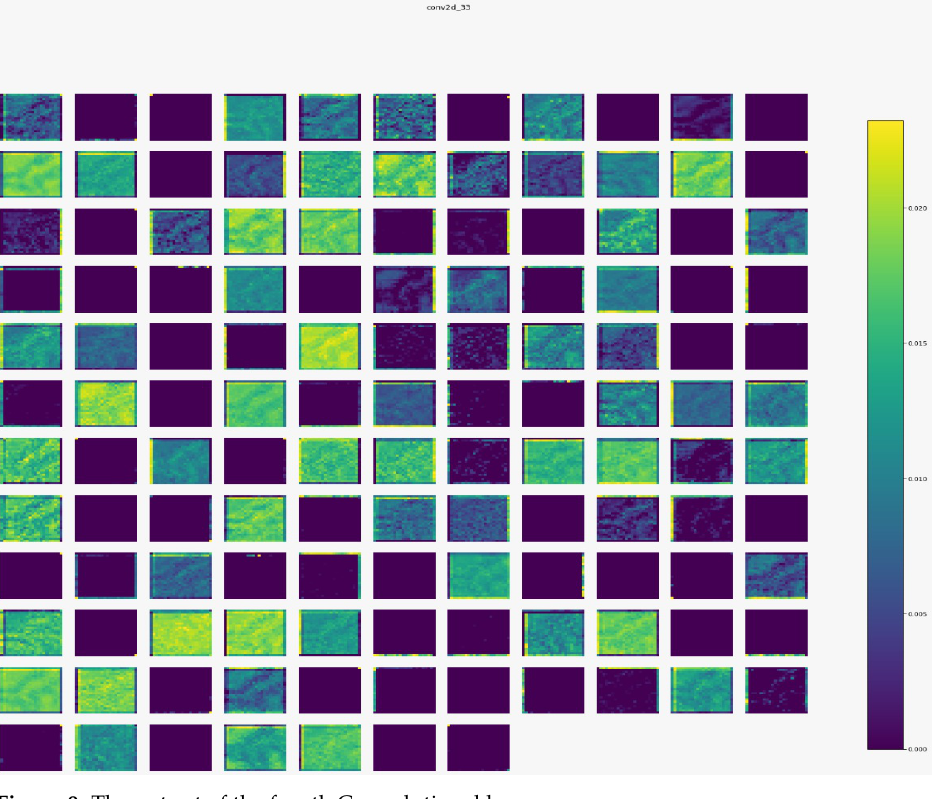
Figure 9. The output of the fourth Convolutional layer